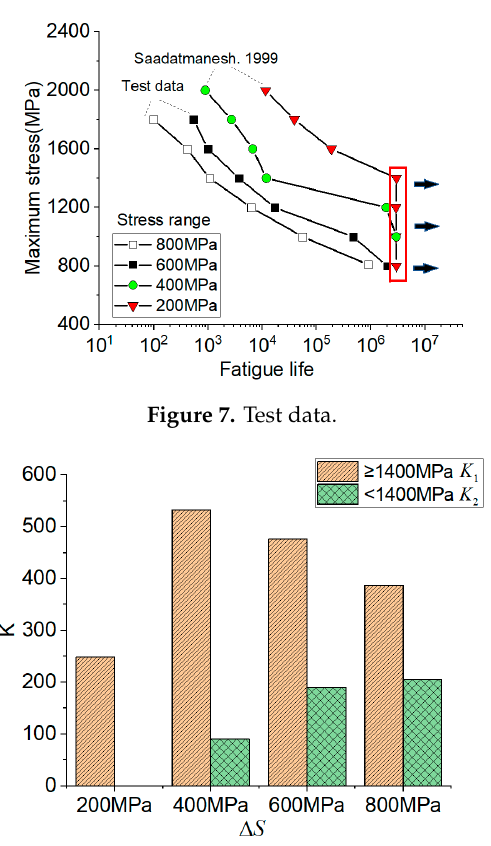
Figure 8. Rate of fatigue life.